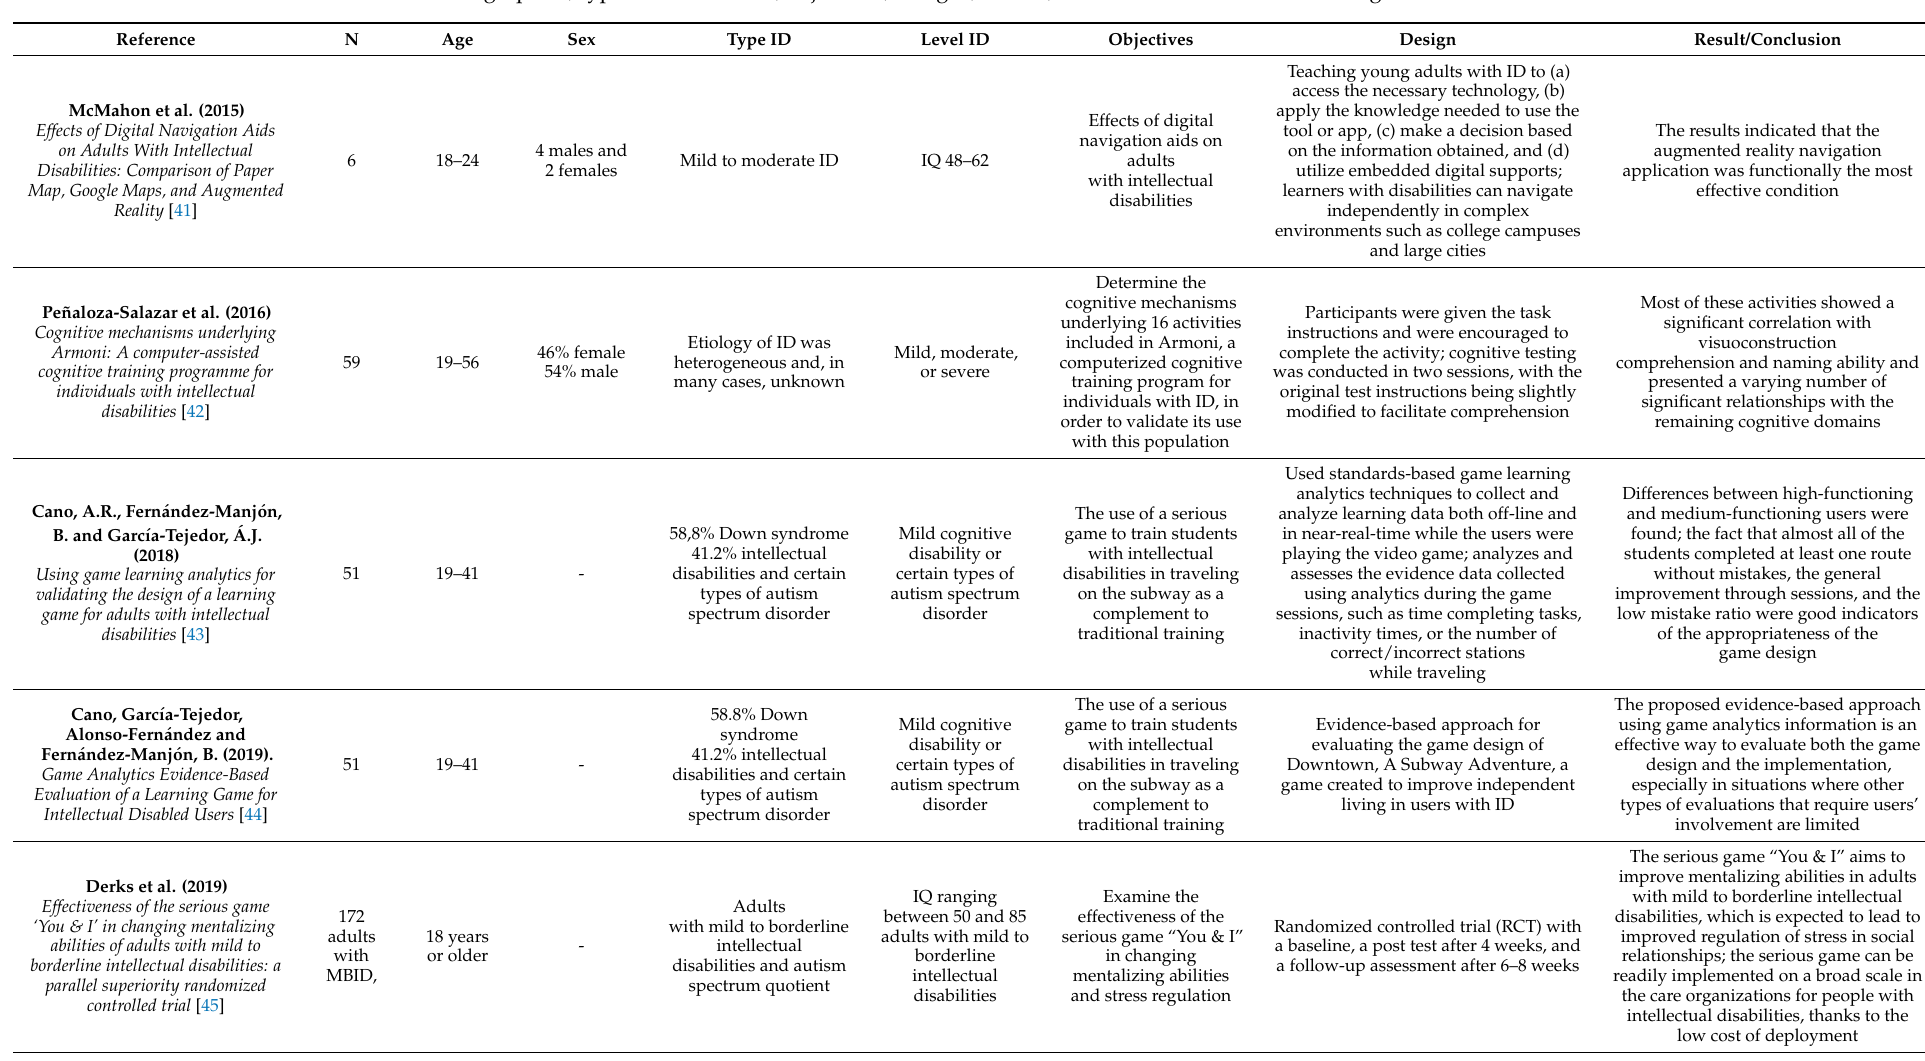
Table 7. Demographics, type and level of ID, objectives, designs, results, and outcome about the serious games